Question: What caption would you write for this figure?
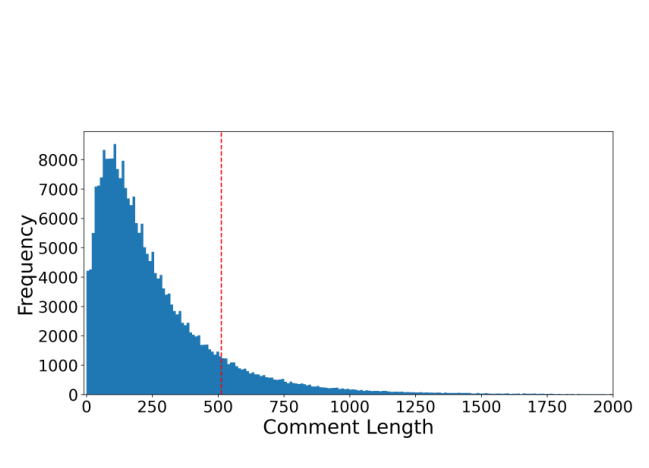
Answer: The histogram of the accumulated comment lengths for each image in AVA-Comments [8]. The vertical dotted line in red indicates a comment length of 512, which is the maximum comment length (Nw) allowed in our experiments.